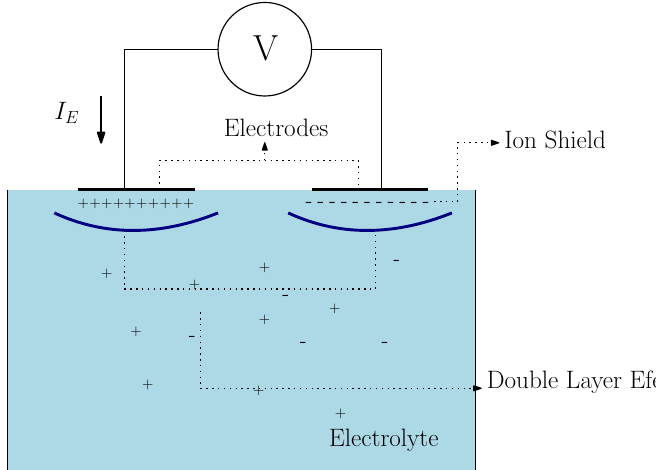
Figure 1. Simplified impedance measurement system of a homogeneous